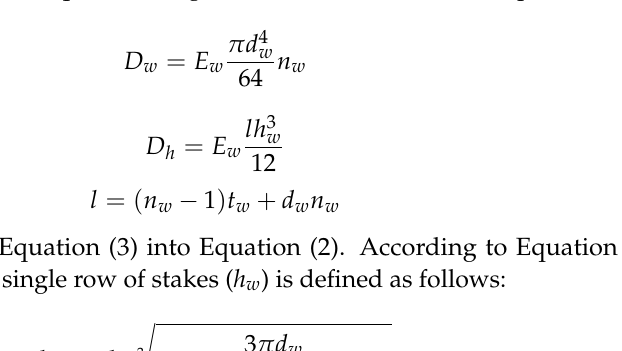
Figure 2. Equivalent of wood piles.